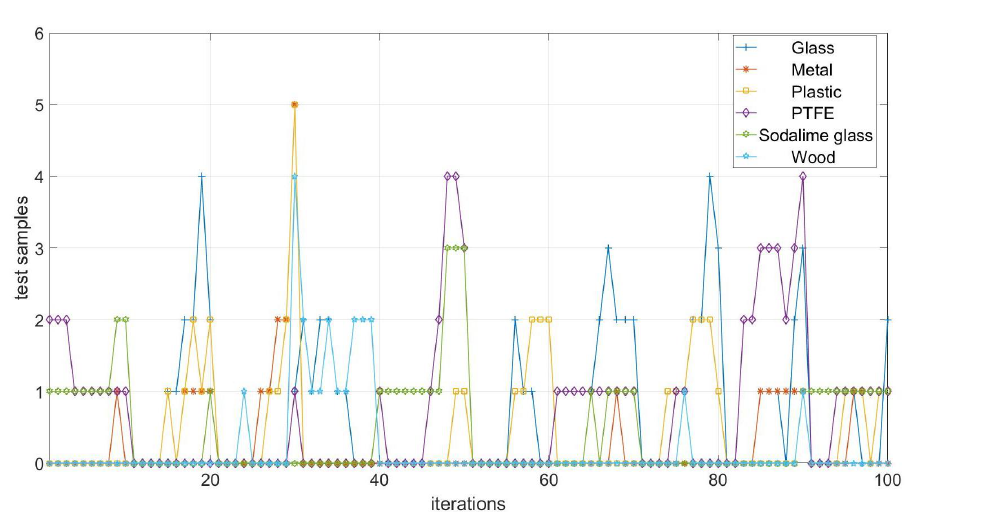
Figure 9. The plot of the misclassified terms FP and FN of the confusion matrices for each contami- nated class alone. The results obtained by the non-linear SVM algorithm trained on the Magnitude only